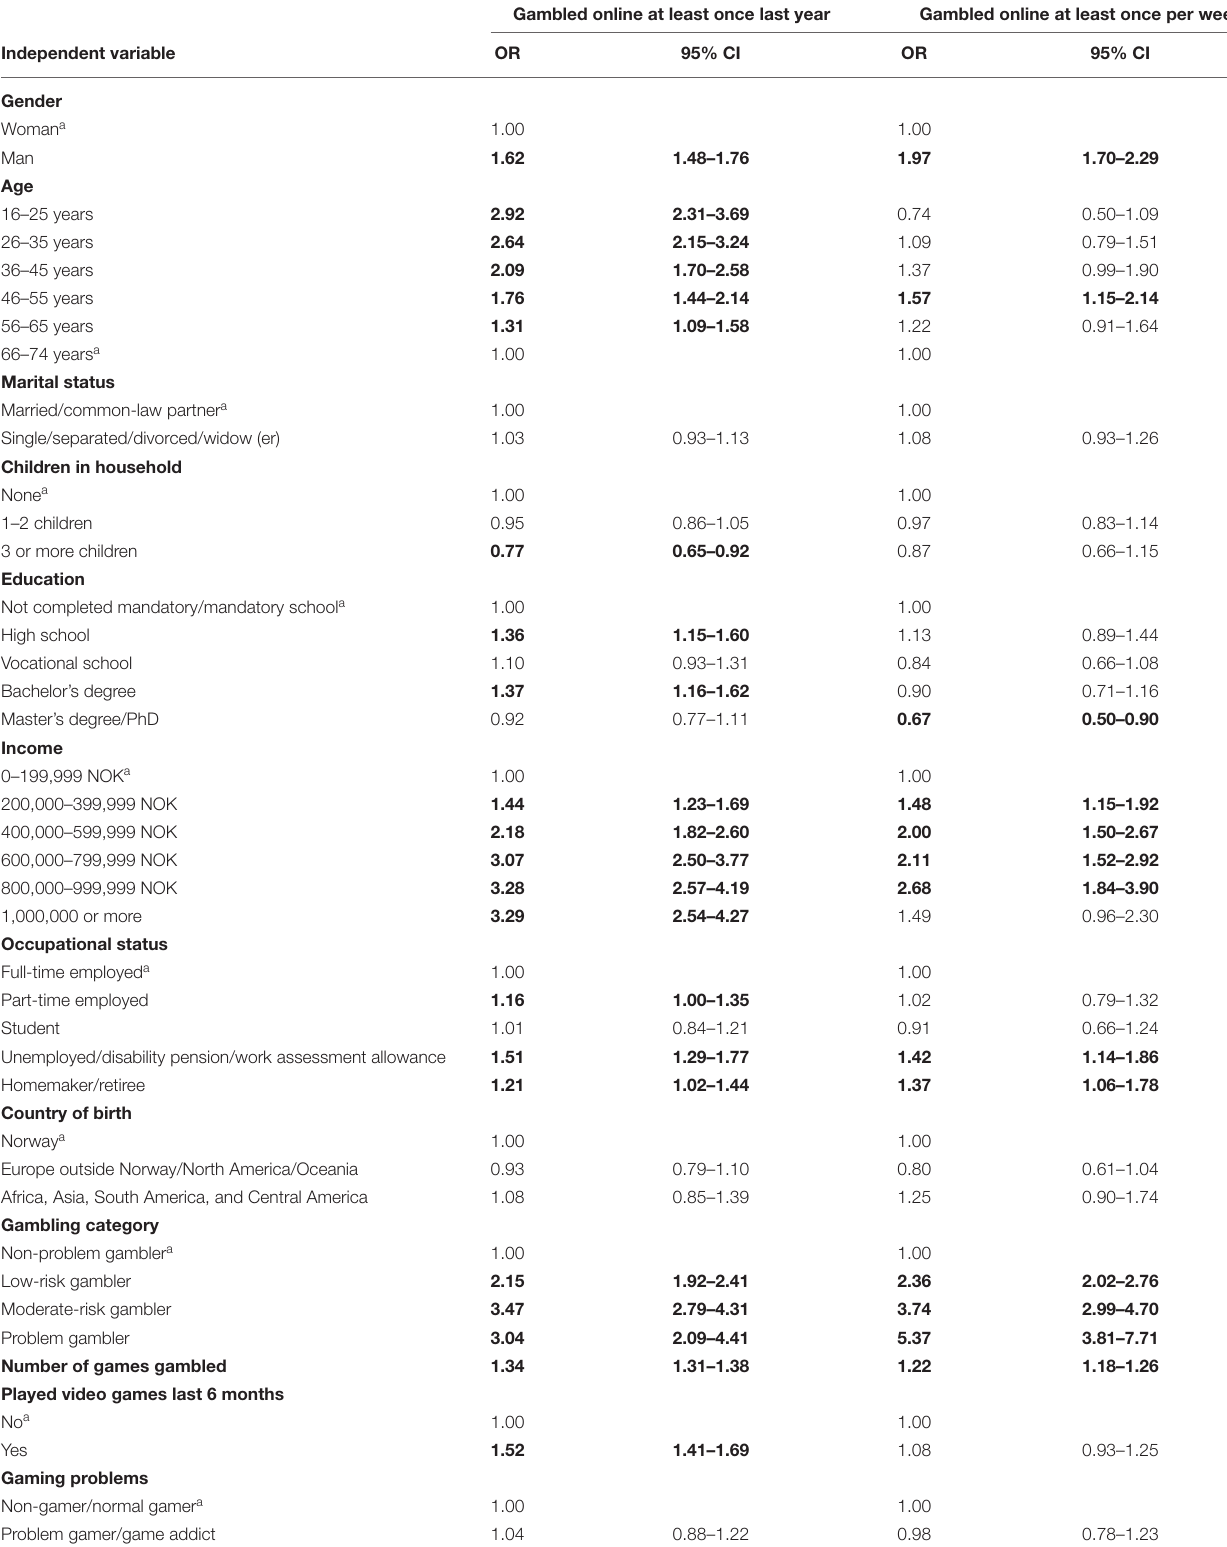
TABLE 3 | Results of logistic regression analysis predicting gambled online at least once last year and gambled online at least once per week among gamblers. Gambled online at least once last